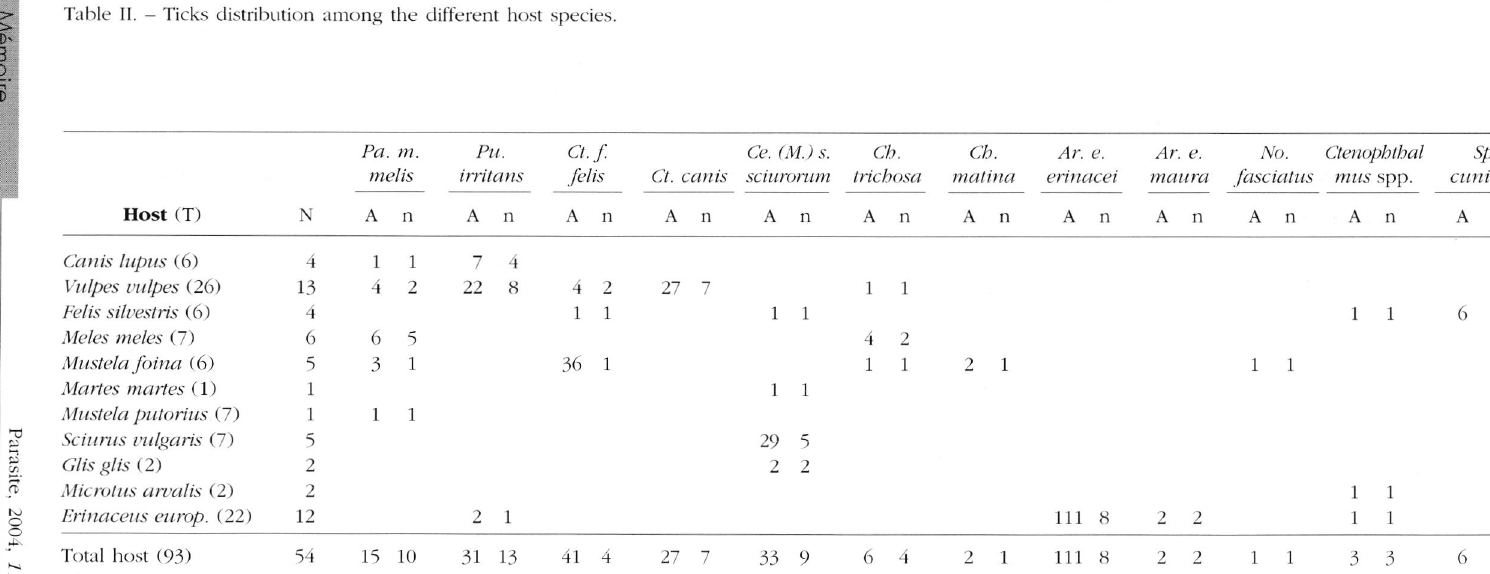
Table 1!. — Ticks distribution among the different host species.